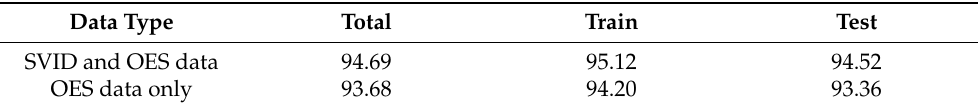
Table 7. Model prediction accuracy results. The unit is %. State variable identification (SVID), optical emission spectroscopy